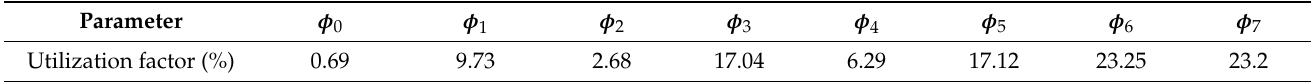
Table 4. Utilization factor of each parameter of feature vector in